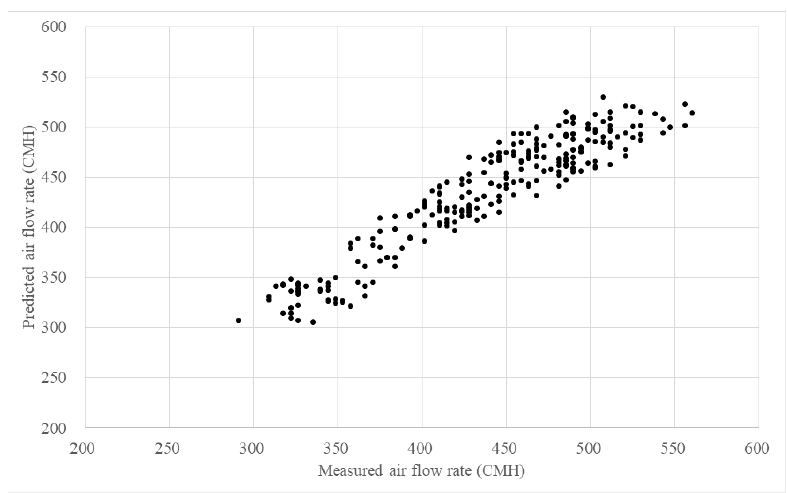
Figure 4. Comparison of measured and predicted air flow rate.